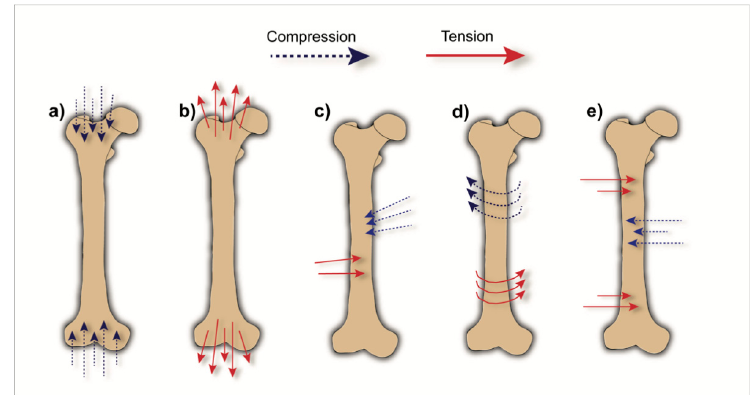
Figure 1. Schematic representation of common types of load acting on a bone: ( a ) compressive load; ( b ) tensile load; ( c ) shear load; ( d ) torsional load; ( e ) bending load.